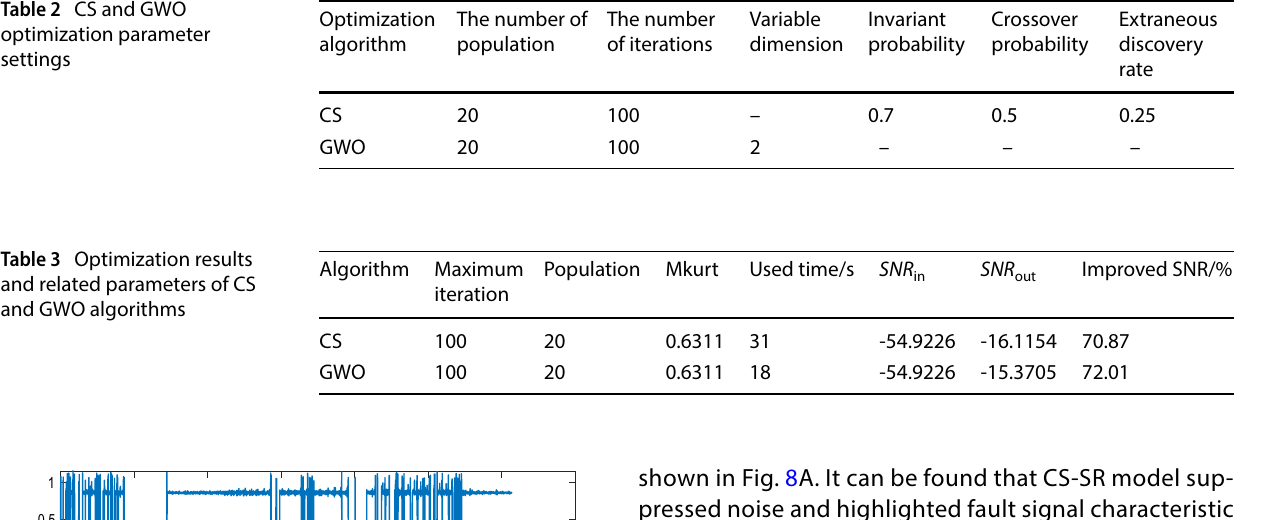
Table 2 CS and GWO optimization